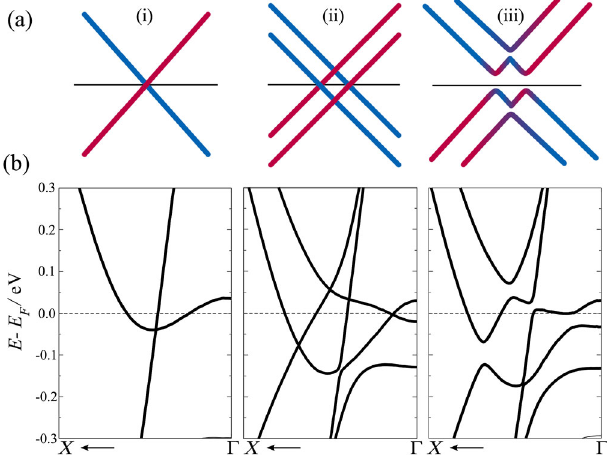
FIG. 8. (a) Hypothetical coupling of two band-inverted mono- layers with type-I Dirac fermions: (a)(i) depicts a doubly degenerate Dirac crossing with vanishing coupling, (a)(ii) a metallic state with two distinct Dirac cones if the nonvanishing coupling preserves the screw symmetry, (a)(iii) a trivial insulator in the case of nonvanishing screw-asymmetric coupling. (b) DFT band structures of bilayer WTe 2 for different intermonolayer couplings: (b)(i) vanishing, (b)(ii) screw-symmetry preserving, and (b)(iii) screw-symmetry